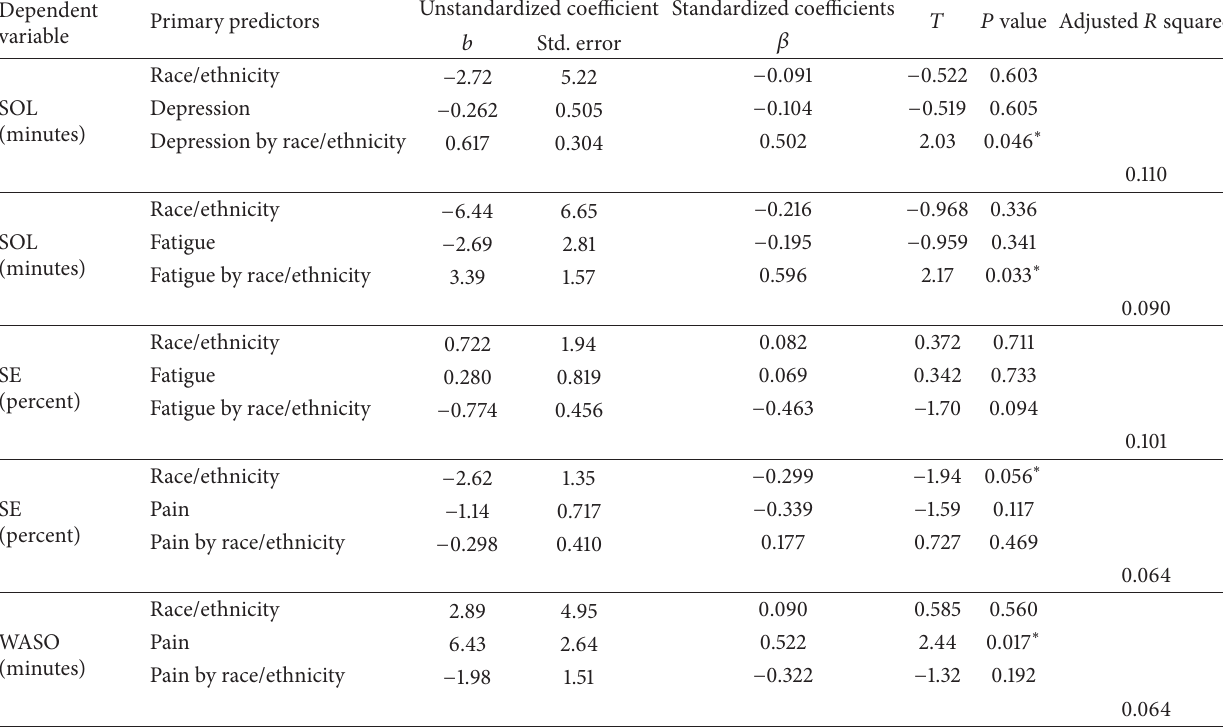
Table 5: Multiple regression analysis of race/ethnicity and symptoms in relation to sleep actigraphy parameters ( 𝑁 = 78 ). Dependent